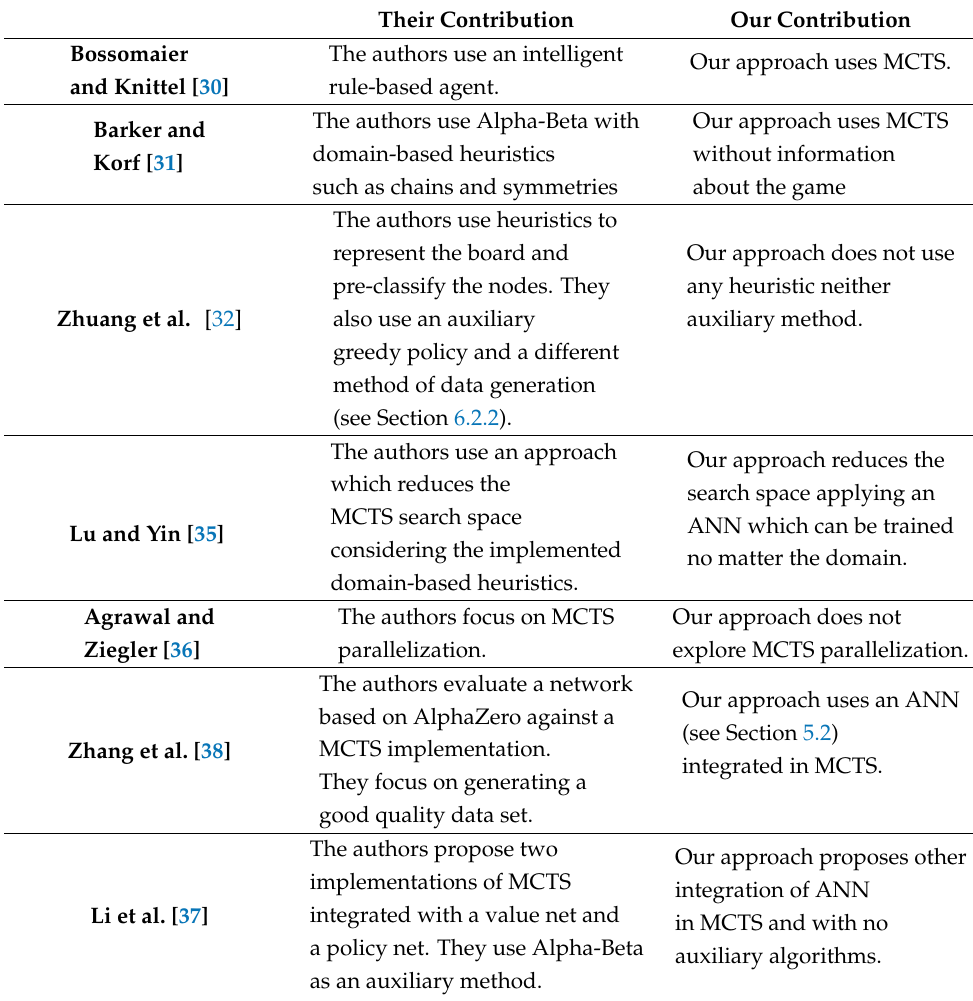
Table 1. Contribution